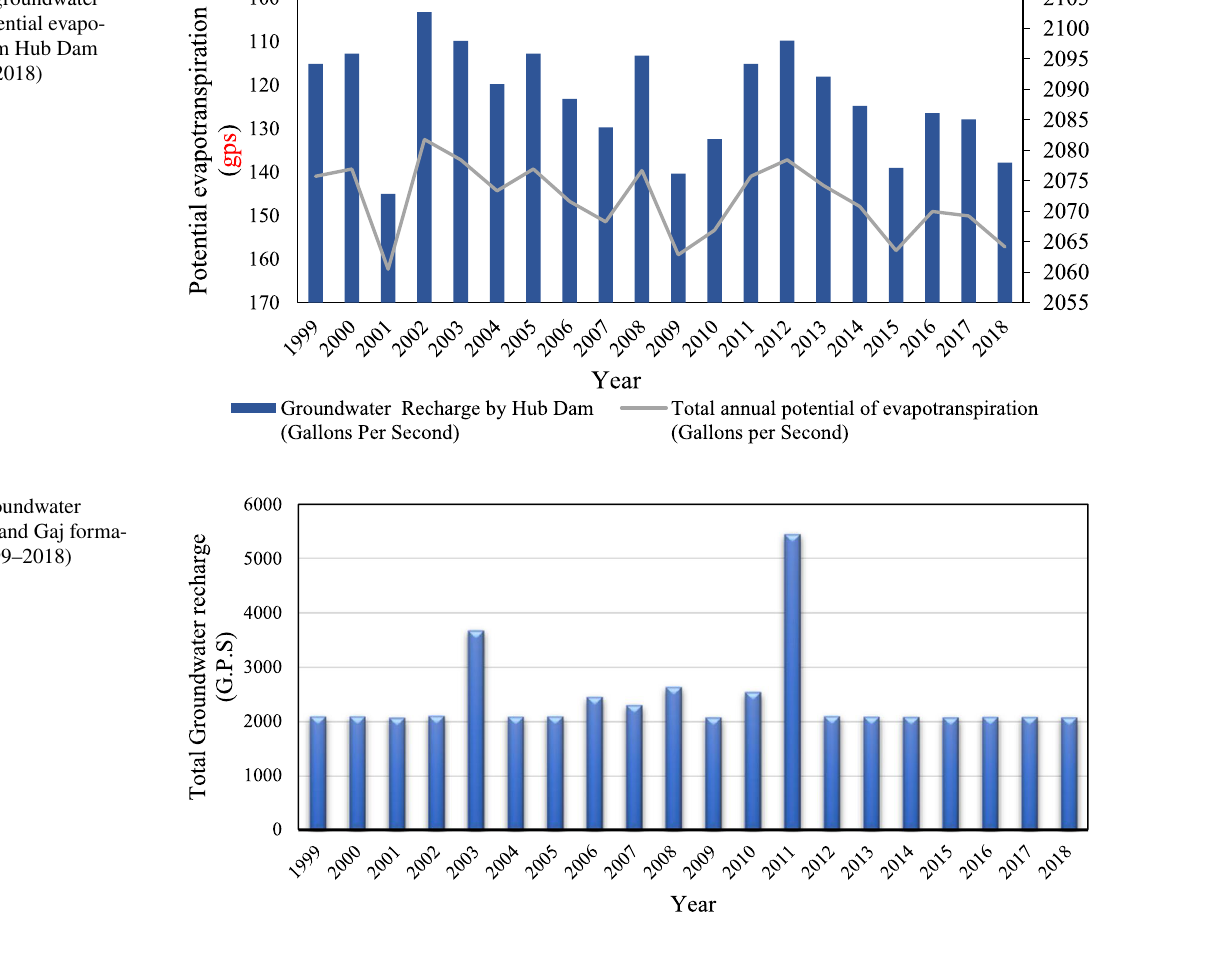
Fig. 13 Annual groundwater recharge and potential evapo- transpiration from Hub Dam